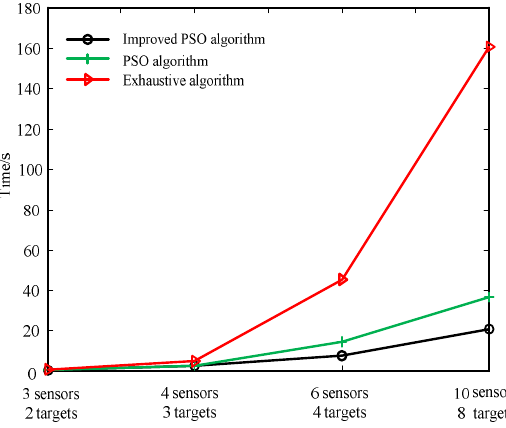
Figure 17 . Running time of an experiment under different solution algorithms.